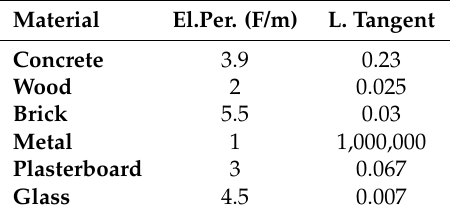
Table 1. Material constitutive parameters of the test environment.